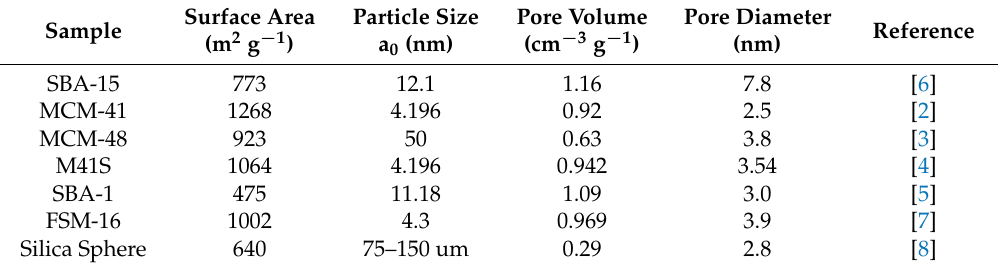
Table 1. Structural properties of the ordered mesoporous silica-based